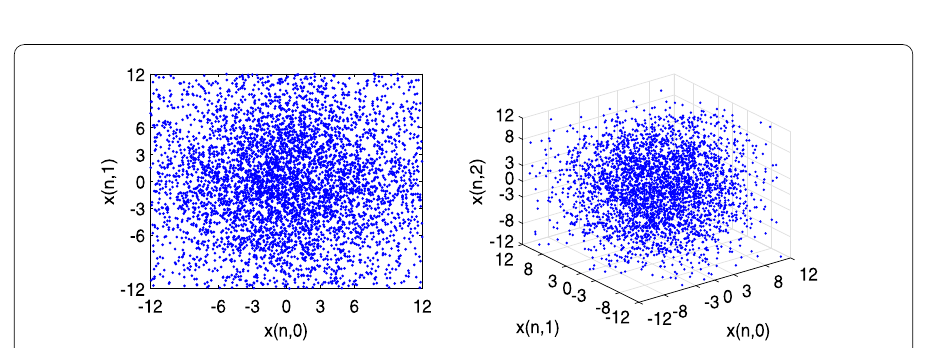
Figure 2 Simulations for system (3) with (6), where n = 0,1, ... ,10,000 and p = 1. In the 2-D graph, k = 1, and the initial values are x (0,0) = 1, x (0,1) = –0.1. In the 3-D graph, k = 2, and the initial value are x (0,0) = 0.1, x (0,1) = –0.1, and x (0,2) = 0.1